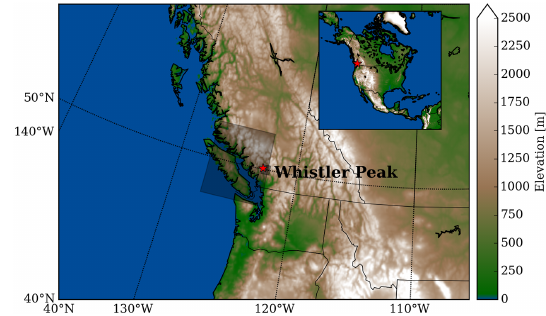
Figure 1. Location and elevation of Whistler Mountain, British Columbia (50.06 ◦ N, 122.96 ◦ W; 2182ma.s.l.). The Whistler Peak measurement site is denoted by a red star. The gray boxes indi- cate the boundaries of the simulated grid boxes used for model– measurement comparisons (0.5 ◦ × 0.667 ◦ resolution for nested and 4 ◦ × 5 ◦ resolution for